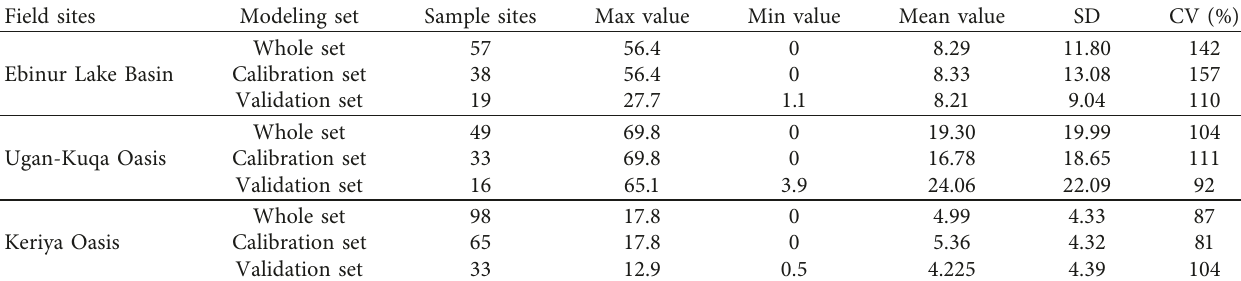
Table 2: Statistical characteristics of SSC in sampling area soil (g · kg − 1